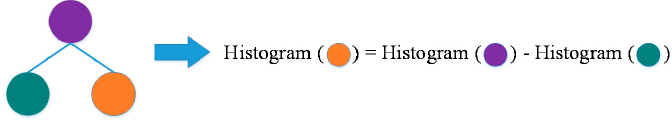
Figure 7. Histogram-based decision tree algorithm.